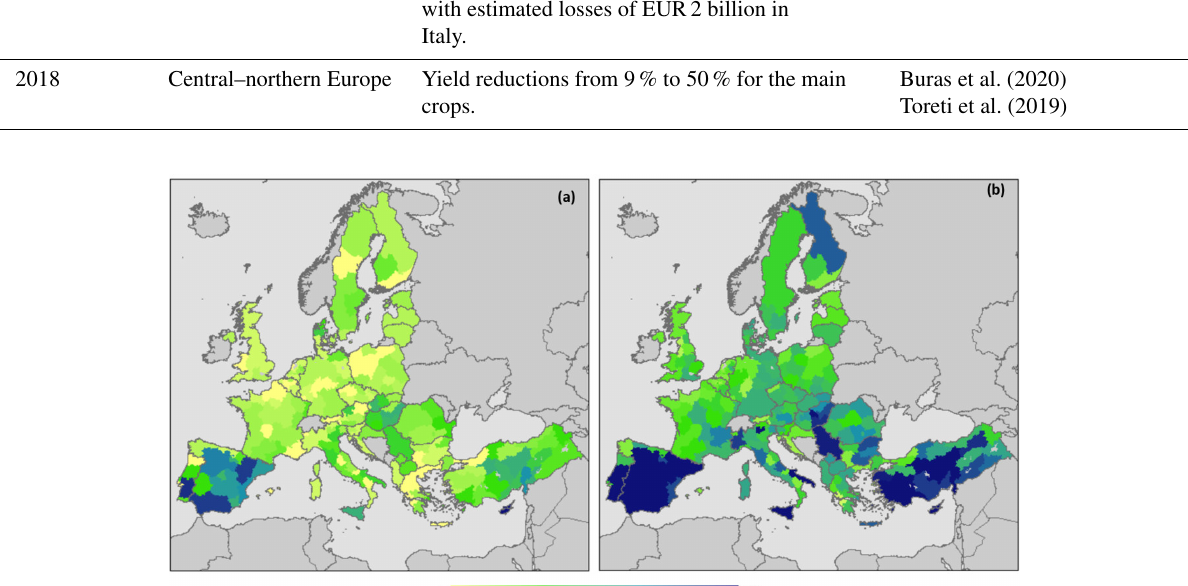
Figure 3. Spatial distribution of the length (in dekads) of the longest period with F p + = 1 ( panel a) and F + = 1 ( panel b) .